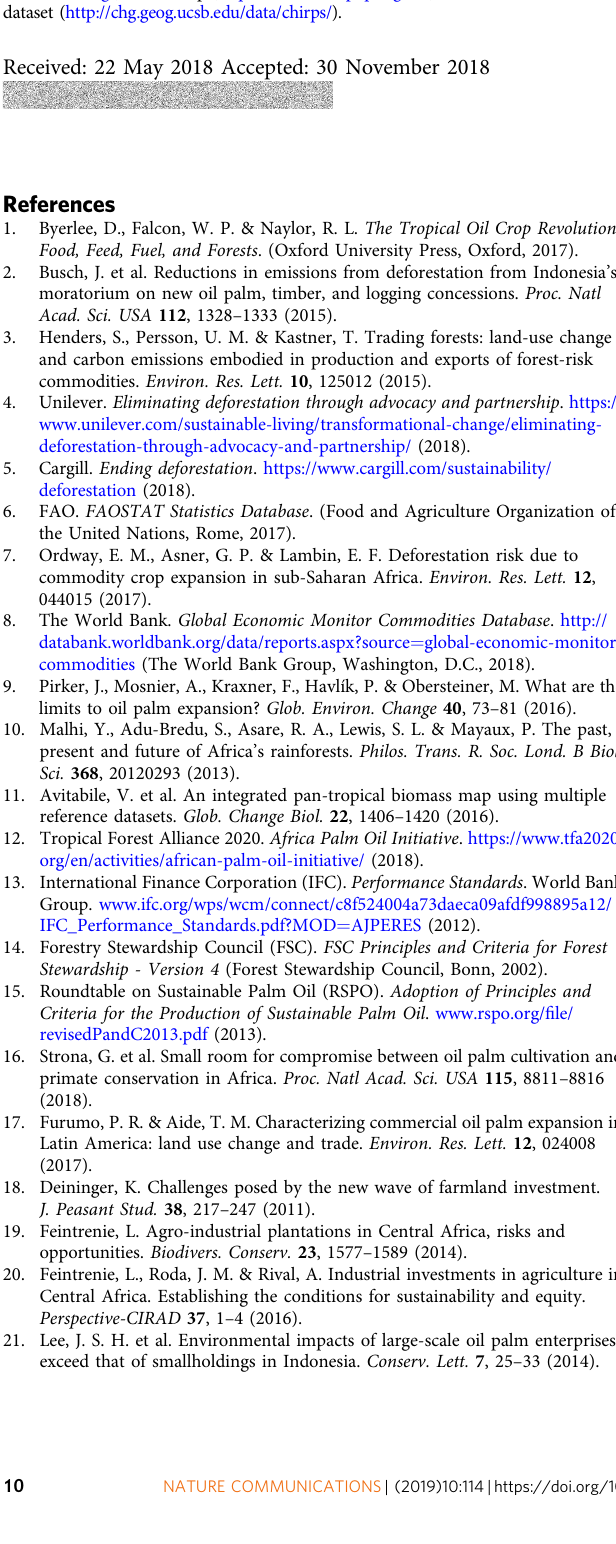
USGS Global Visualization Viewer (GloVis) website (https://glovis.usgs.gov/), or the Google Earth Engine API (https://code.earthengine.google.com/). The land org/10.18735/4nse-8871 ’ , ‘ https://doi.org/10.18735/952x-w447 ’ , ‘ https://doi.org/ 10.18735/0mw1-qq72 ’ . Mill data used in the spatial models are available aggregated at Supplementary Table 3, came from the WRI Forest Atlas of Cameroon (http://cmr. forest-atlas.org/), WorldPop (http://www.worldpop.org.uk/), and the CHIRPS rainfall dataset